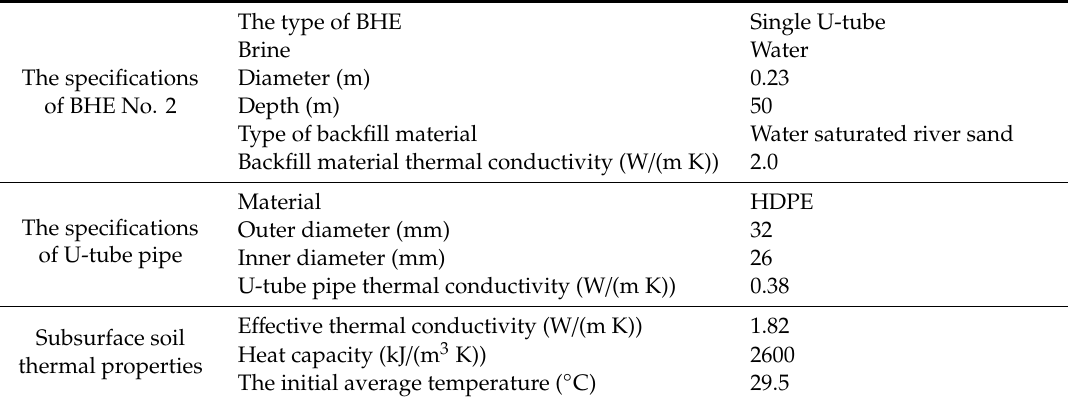
Table 4. The specifications and thermal properties of BHE No.